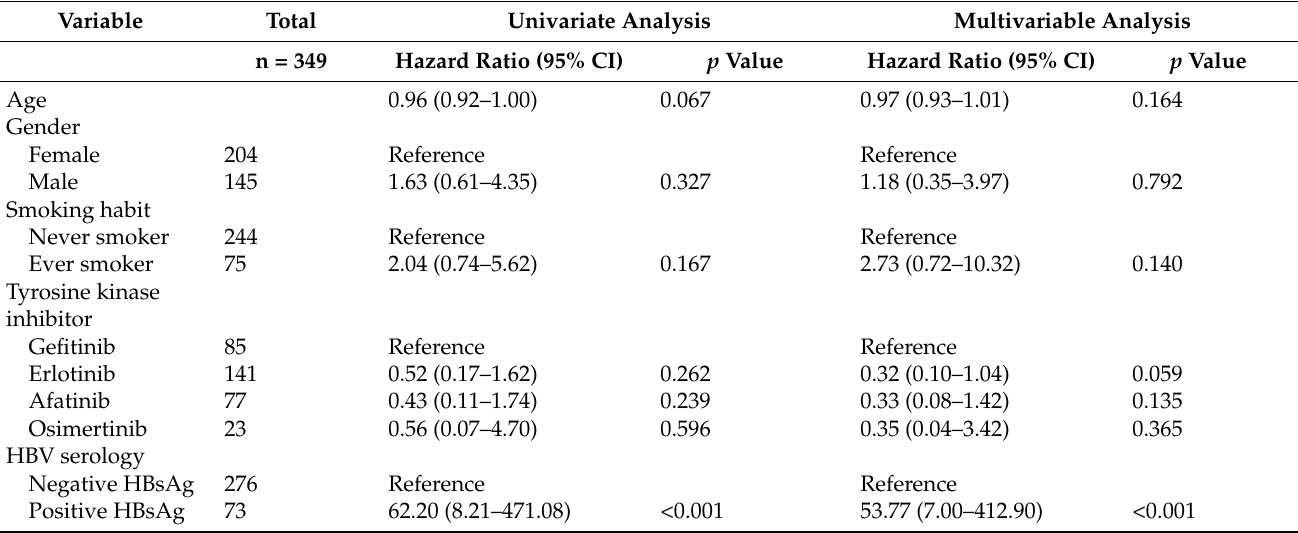
Table 3. Univariate and multivariable analysis for HBV reactivation in lung cancer patients receiving tyrosine kinase inhibitor treatment